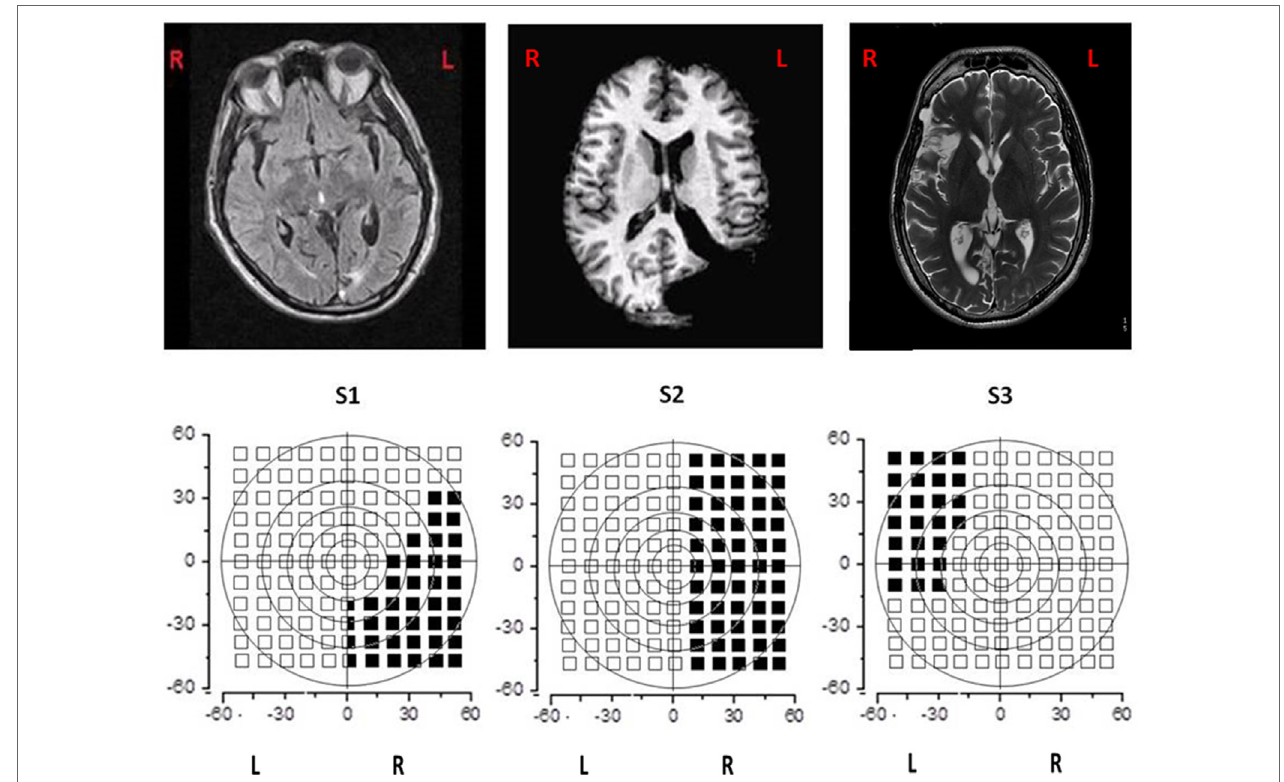
FIgUre 1 | Magnetic resonance imaging of the brain and visual field campimetry of S1, S2, and S3.